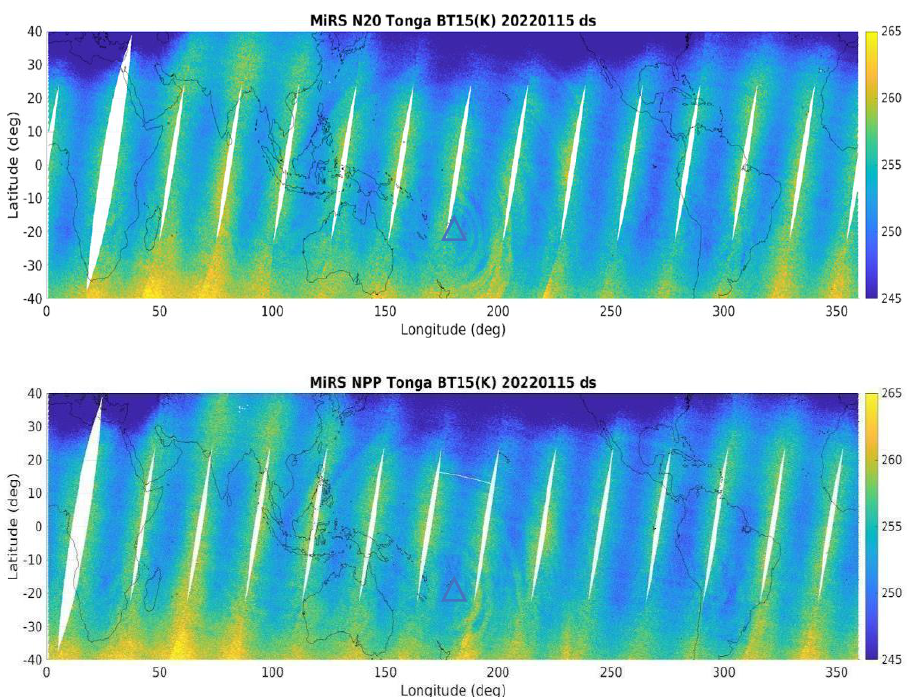
Figure 2. ATMS Channel 15 (57.3 GHz) measured brightness temperatures NOAA−20 (upper panel) and S-NPP (lower panel) at descending (ds) node on 15 January 2022. In the figure, triangles indicated the approximate location of the volcano.